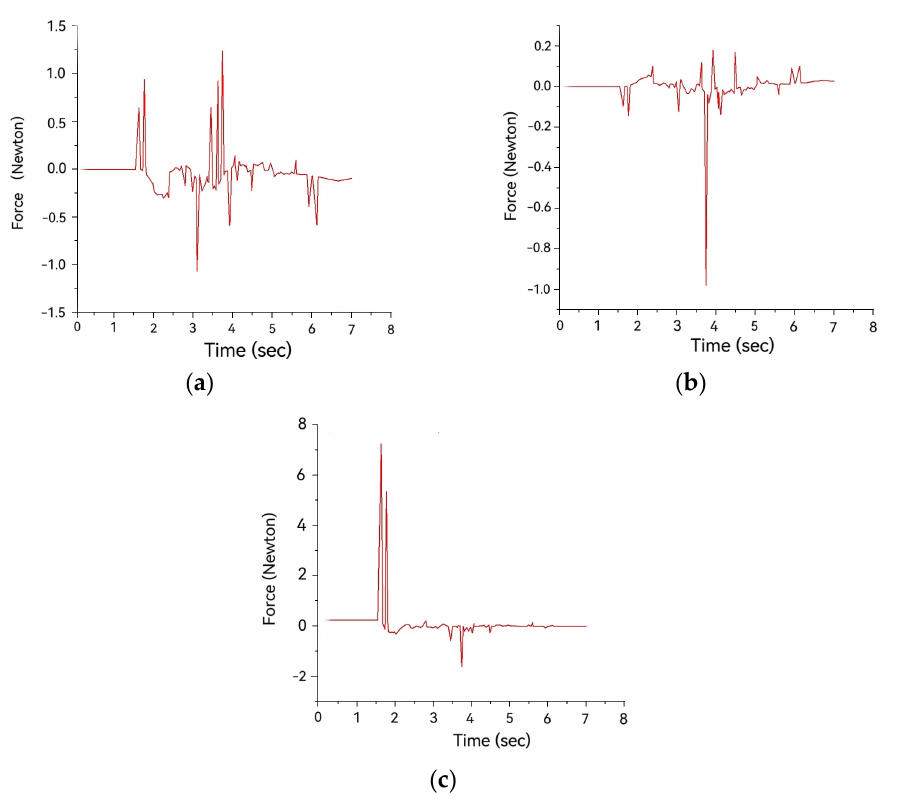
Figure 14. When the coupling was bent, the force was applied along the x − , y − and z − axis. ( a ) Vibra- tion force in the x − axis direction. ( b ) Vibration force in the y − axis direction. ( c ) Vibration force in the z − axis direction.